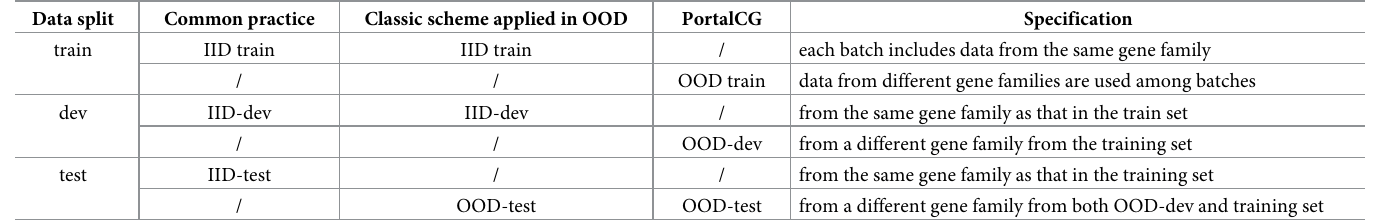
Table 1. Data split scheme for stress model instance